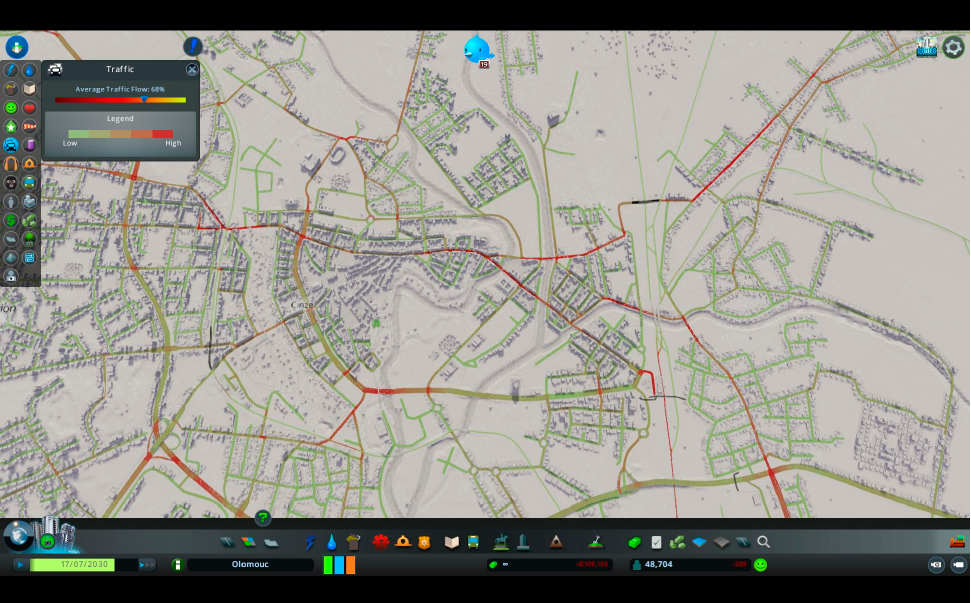
Figure 11. Traffic info view of the Cities: Skylines’ model of Olomouc.